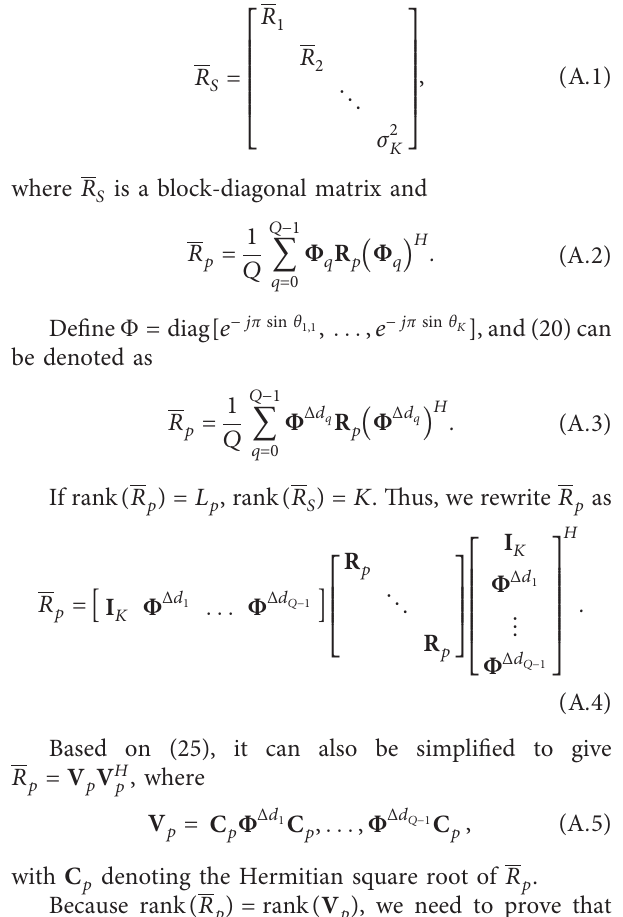
Figure 8: The RMSE versus the number of snapshots in different sparse arrays using